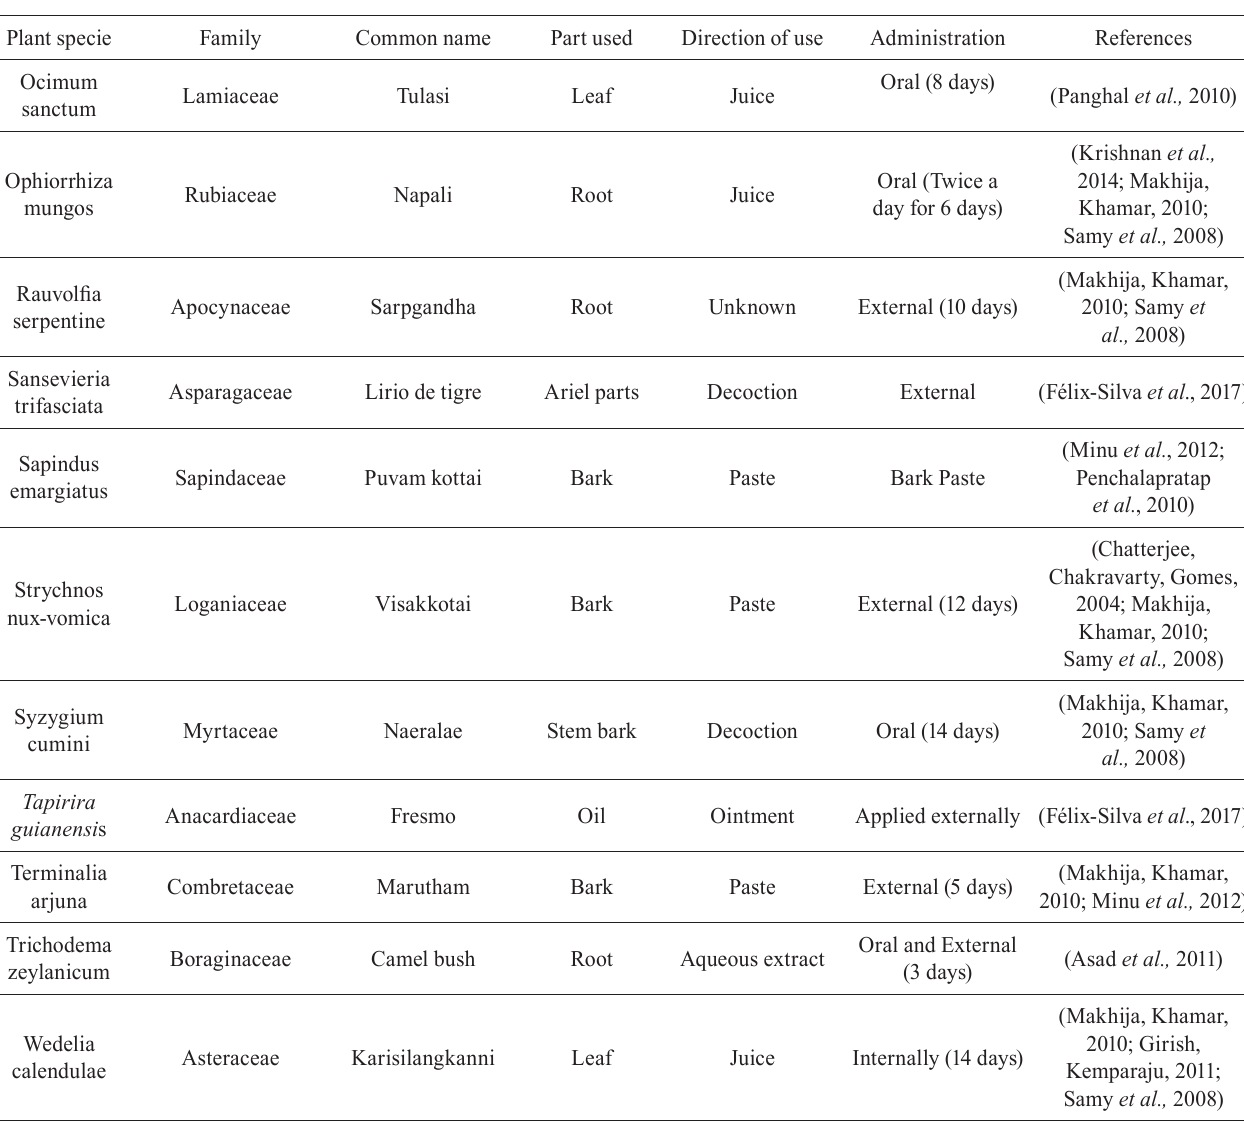
TABLE I - T raditionally used plants for Snakebite Management Plant